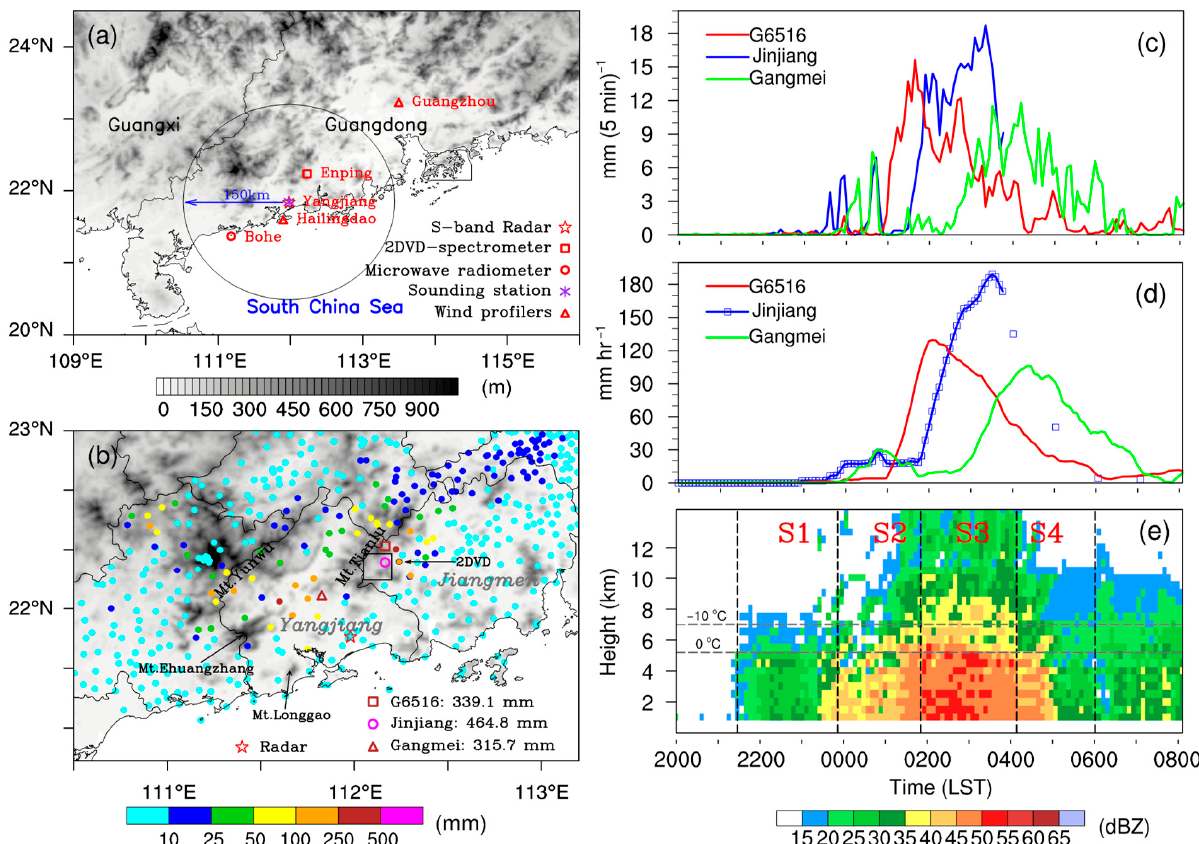
Figure 1. ( a ) Topography (shading) of South China and its vicinity. The South China Sea and the provinces of Guangdong and Guangxi are labeled. The locations of the YJ S-POL and 2DVD, the microwave radiometer, the YJ sounding station, and wind profiler radars are denoted by a red pentacle, a red square, a red circle, a purple asterisk, and two red triangles, respectively. The circle has a radius of 150 km and is centered on the YJ S-POL. ( b ) Distribution of the accumulated rainfall at 2000 LST 21–22 June 2017 based on rain gauge observations. Grey shading represents the topography; The small box denotes the key region around Jinjiang. Mt. Tianlu, Mt. Yunwu, Mt. Ehuangzhang, and Mt. Longgao are labeled. The stations with the top three rainfall accumulations are labeled. ( c ) Time series of the rainfall rate (5-min rain rate) and ( d ) the hourly rainfall accumulation (accumulated every 5 min) recorded at the stations of Jinjiang (blue line), G6516 (red line), and Gangmei (green line), whose locations are given in ( b ). ( e ) Time–height distribution of Z H over Jinjiang (a 10 km × 10 km area centered on Jinjiang station). The dashed lines mark the four stages.